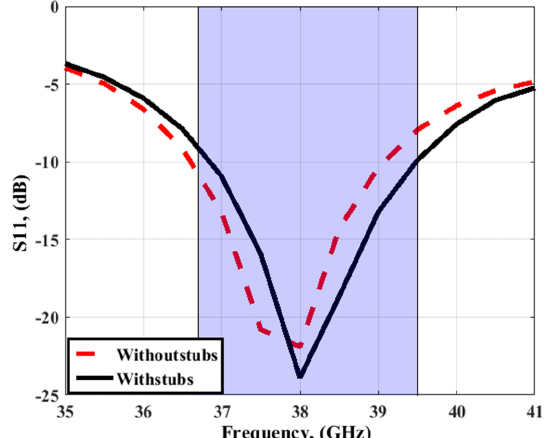
Figure 5. The 2D configuration of the 4-port MIMO antenna ( a ) without stubs and ( b ) with stubs.